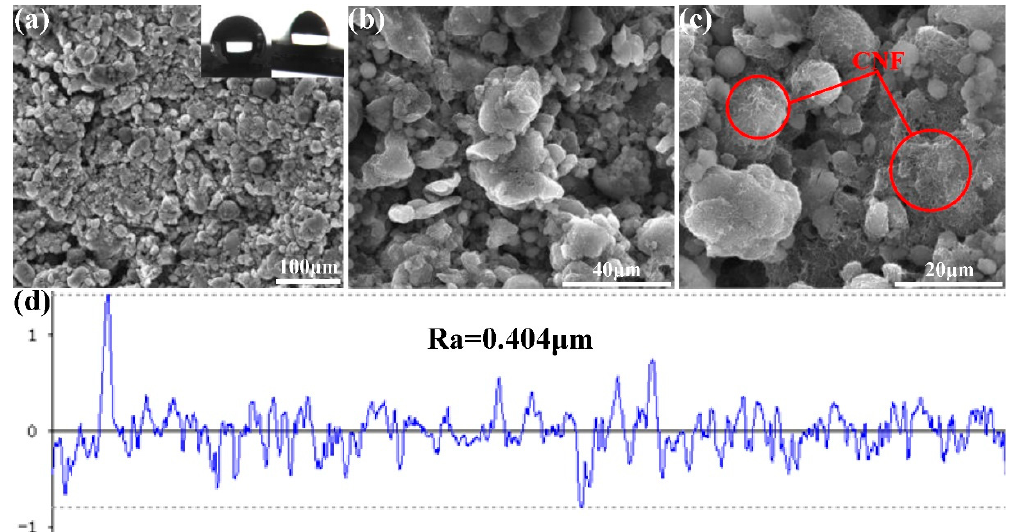
Figure 3. Surface morphologies under different magnifications: (( a ) 600× SEM image; ( b ) 2500× SEM image; and ( c ) 5000× SEM image). The insets in Figure 3a are images showing the water contact angle (WCA), and a low sliding angle (SA); ( d ) the surface roughness value and curve of the obtained flexible conductive superhydrophobic (FCS) coating.